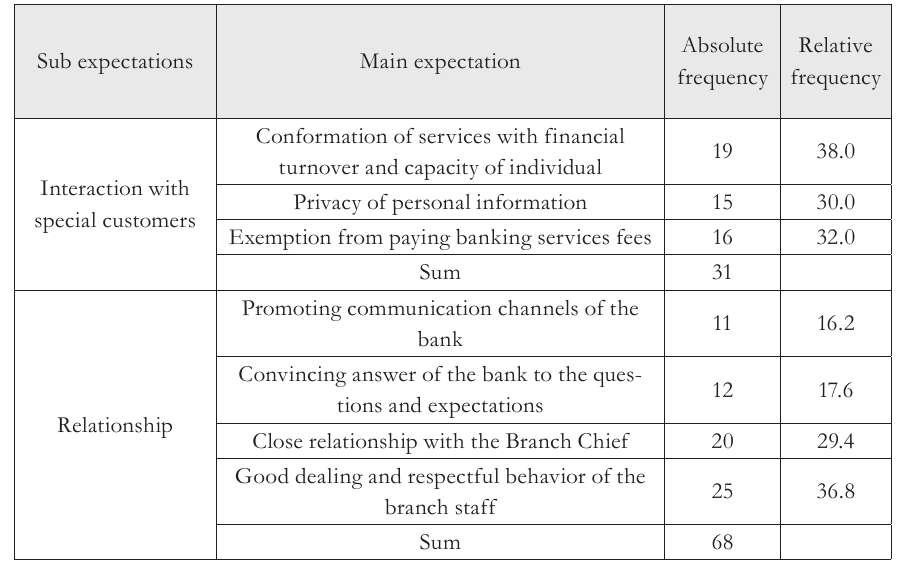
Tab. 3 - Relative and absolute frequency of major and sub expectations of the medical sector based on interviews (Source: